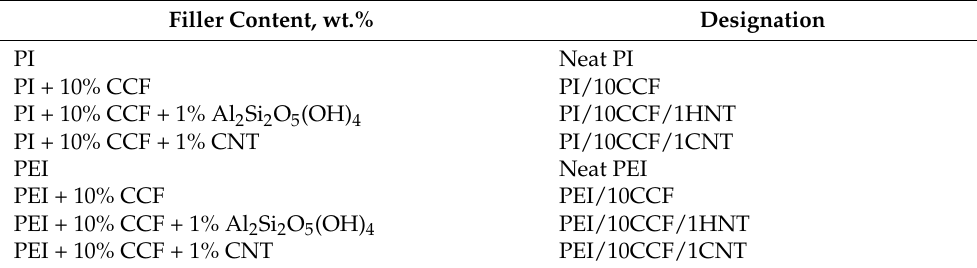
Table 1. The compositions of the investigated nanocomposites. Filler Content,